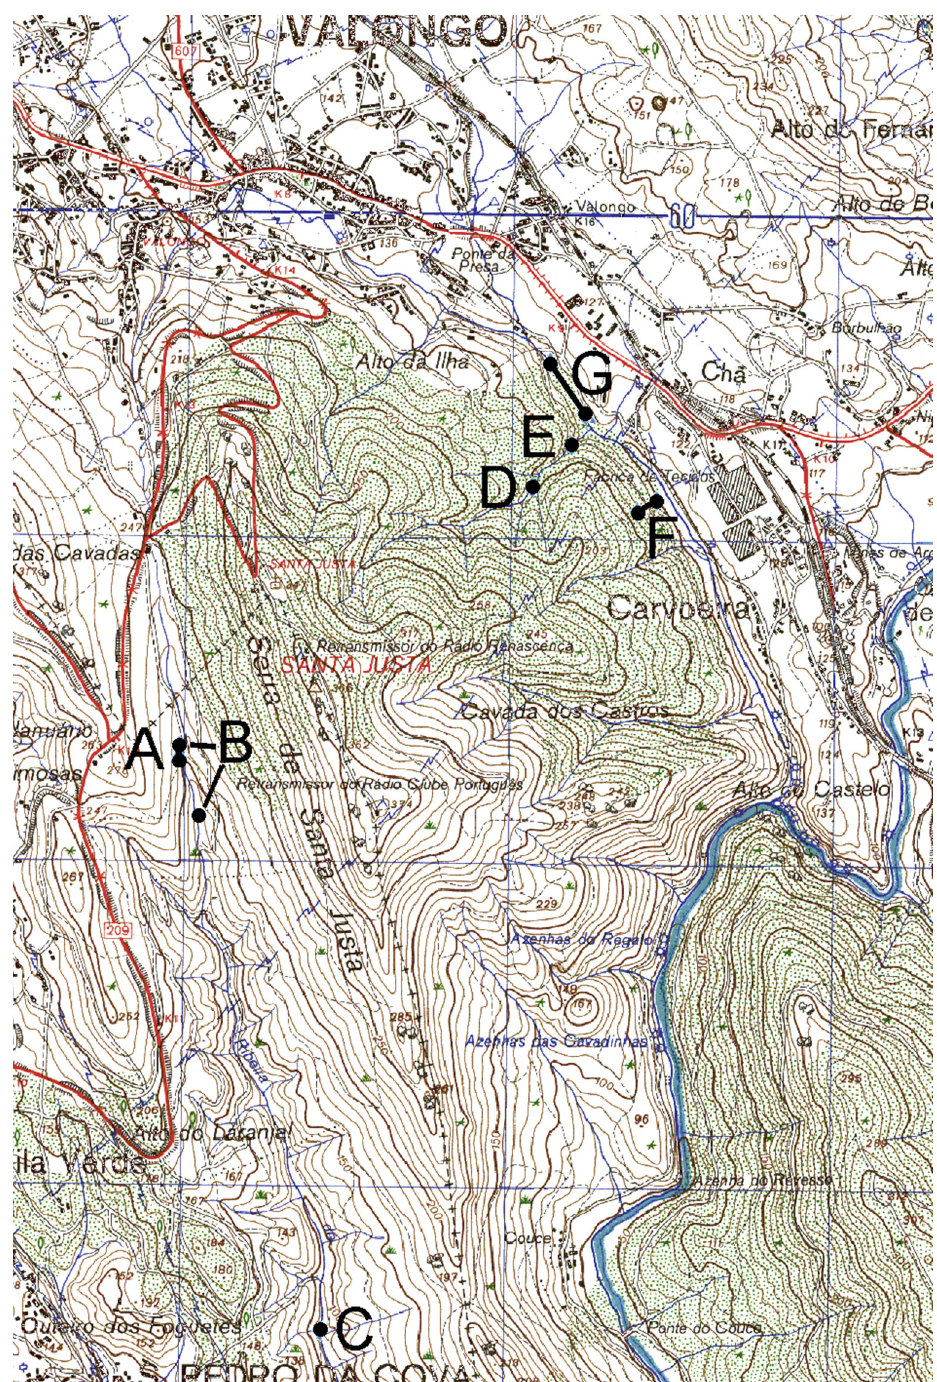
Figure A1. Map of the Valongo–São Pedro da Cova area with the Serra de Santa Justa [63]. The blue squares have a size of one km 2 . Points of interest are: A: dam; B: research section of the Ribeira de Silveirinhos; C: newly created pond in the Silveirinhos streambed; D: entrance of Upper mine at Poço do Inferno; E: entrance of Lower mine; F: Simão mine (no data presented, inaccessible for man since 2010); and G: covered stretch of the Simão river. Note that the two study areas are in clockwise direction interconnected downstream through the Poço do Inferno-Simão-Ferreira river and upstream through the